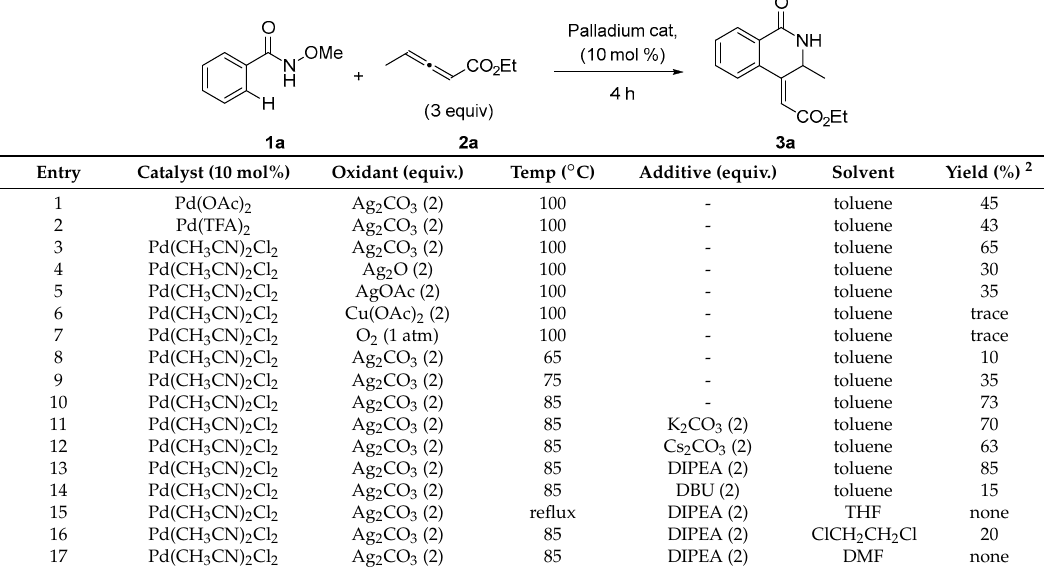
Table 1. Selected results for the optimization of the reaction conditions for oxidative annulation. 1